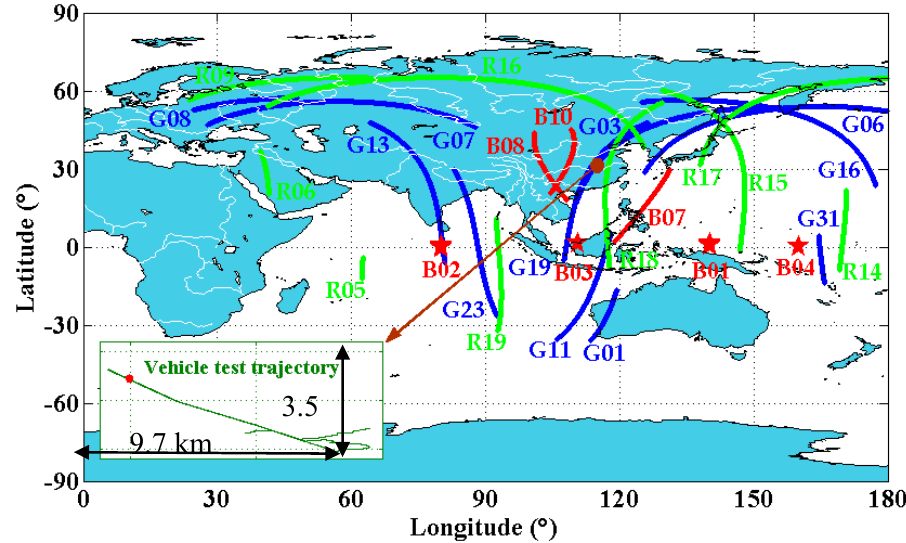
Figure 3. Sky-plot of available GPS (G) satellites ( Blue ), BeiDou (B) satellites ( Red ), and GLONASS (R) satellites ( Green ) of land vehicle experiment on 19 June 2013 in Wuhan, China, respectively; the lower-left subfigure is the trajectory of this test.